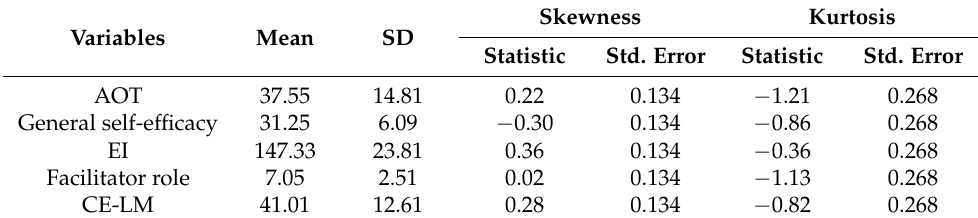
Table 1. Descriptive statistic—mean, SD, skewness, and kurtosis.